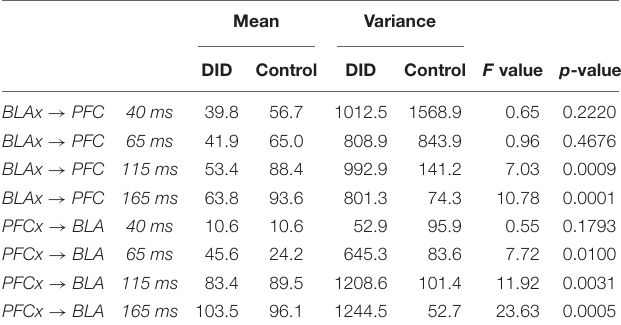
TABLE 1 | F -test of Two-Sample